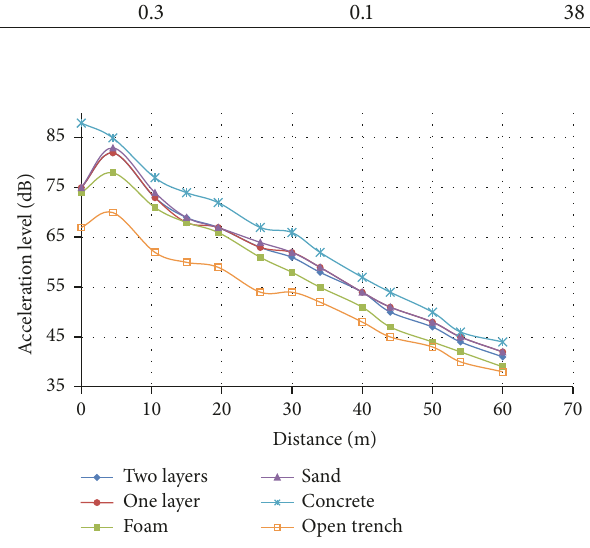
Figure 6: The relationship between the acceleration level and distance under case 1